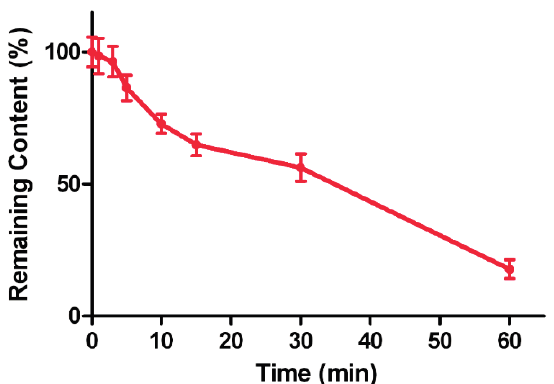
Figure 5. Elimination curves of triptolide after incubation in human liver microsomes in vitro